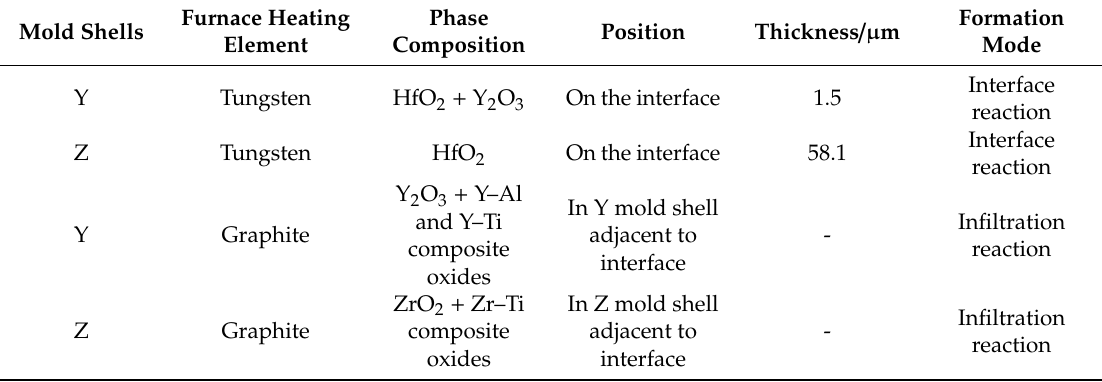
Table 2. Interface and near-interface characteristics of the